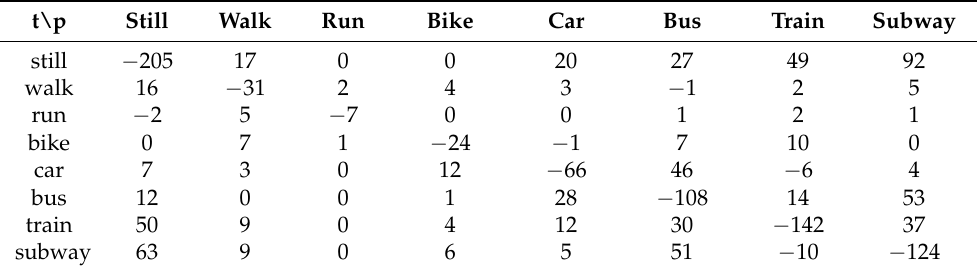
Figure 12. The 2D encoded representation of the last activations of the LSTM layer for the linear acceleration software sensor. Color codes: blue (still), orange (walk), green (run), red (bike), violet (car), brown, (bus), pink (train), grey (subway). Table 8. The difference confusion matrix of the network trained without the magnetometer. The largest loss in classification occurred in the class still and the smallest in class run . t = true label, p = predicted